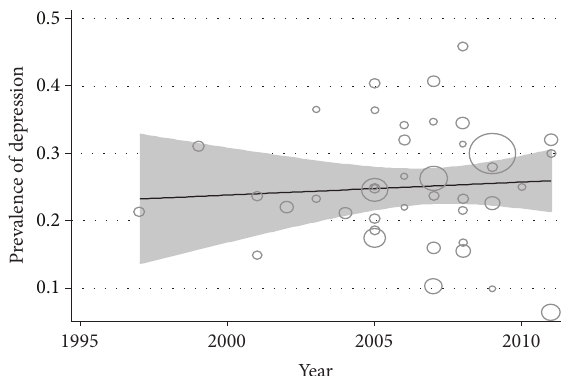
Figure 5: Prevalence of postpartum depression among Iranian women at different study